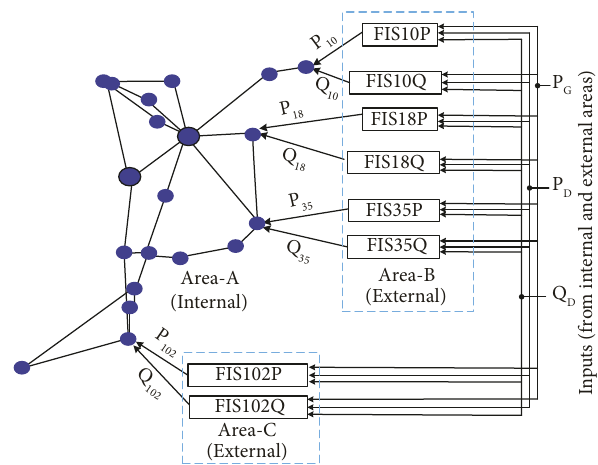
Figure 7: Representation of external areas by dependent loads. Table 1: Comparison of original and reduced system with external